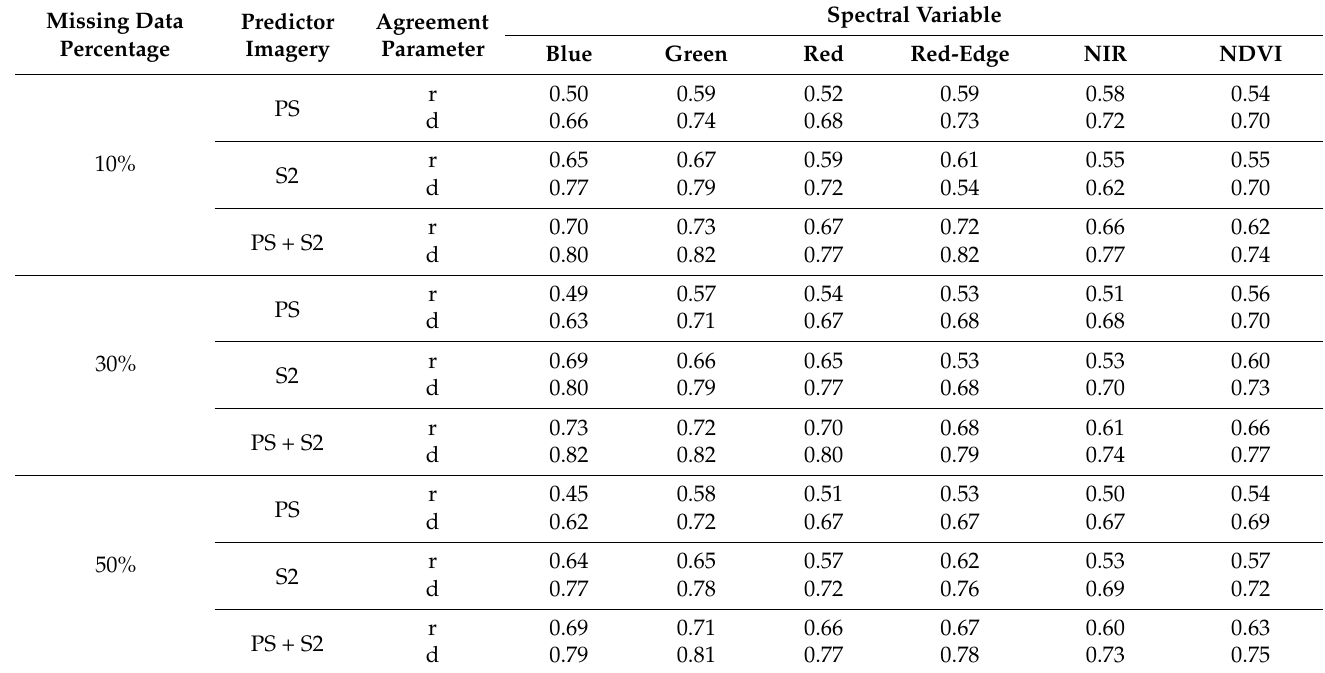
Table 2. Spatial agreement between original and imputed UAV